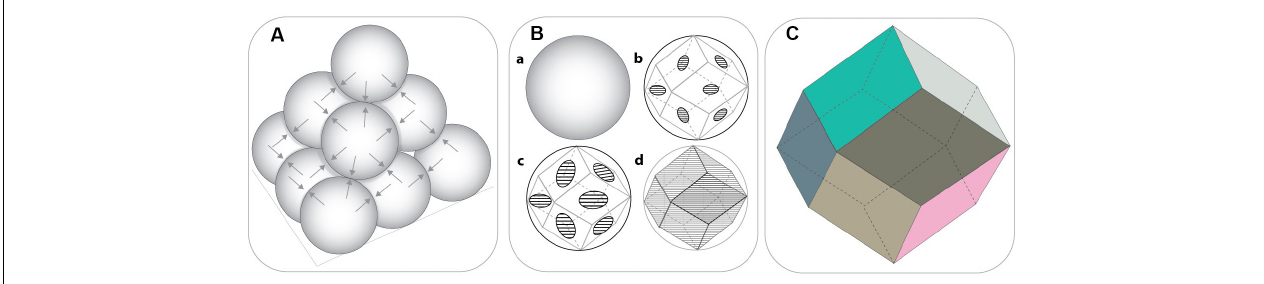
FIGURE 5 | (A) Closest packing density of the solid spheres (non-deformed) (74.048%) where each sphere touches twelve other spheres. (B) The transition from sphere to rhomboidal dodecahedron (RDH) by the gradual flattening of the touching points. (C) The geometry of the basic RDH. [Adapted images were recreated using Ref. Lissant (1966) as a